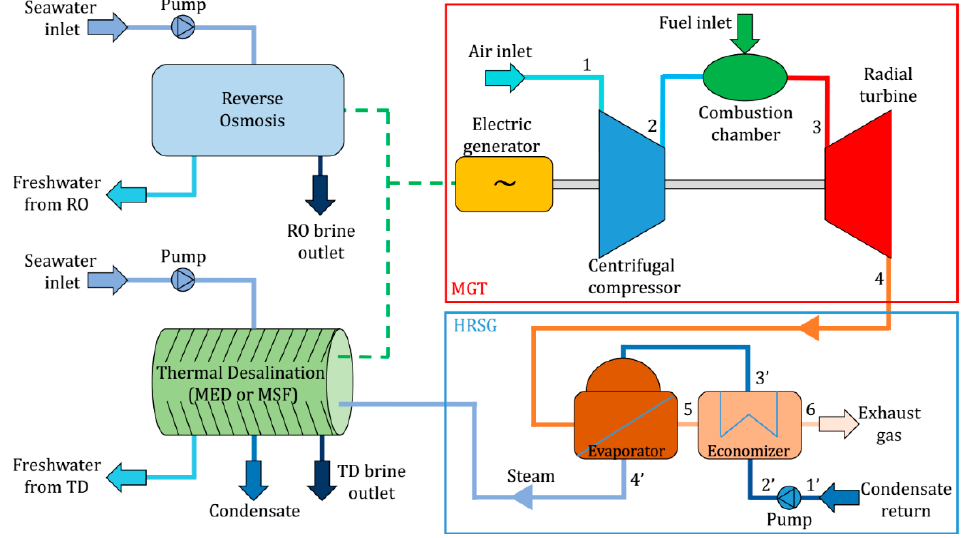
Figure 1. Schematic of the hybrid desalination plant coupled with the GT CHP system. Table 1. Operational and performance parameters of the